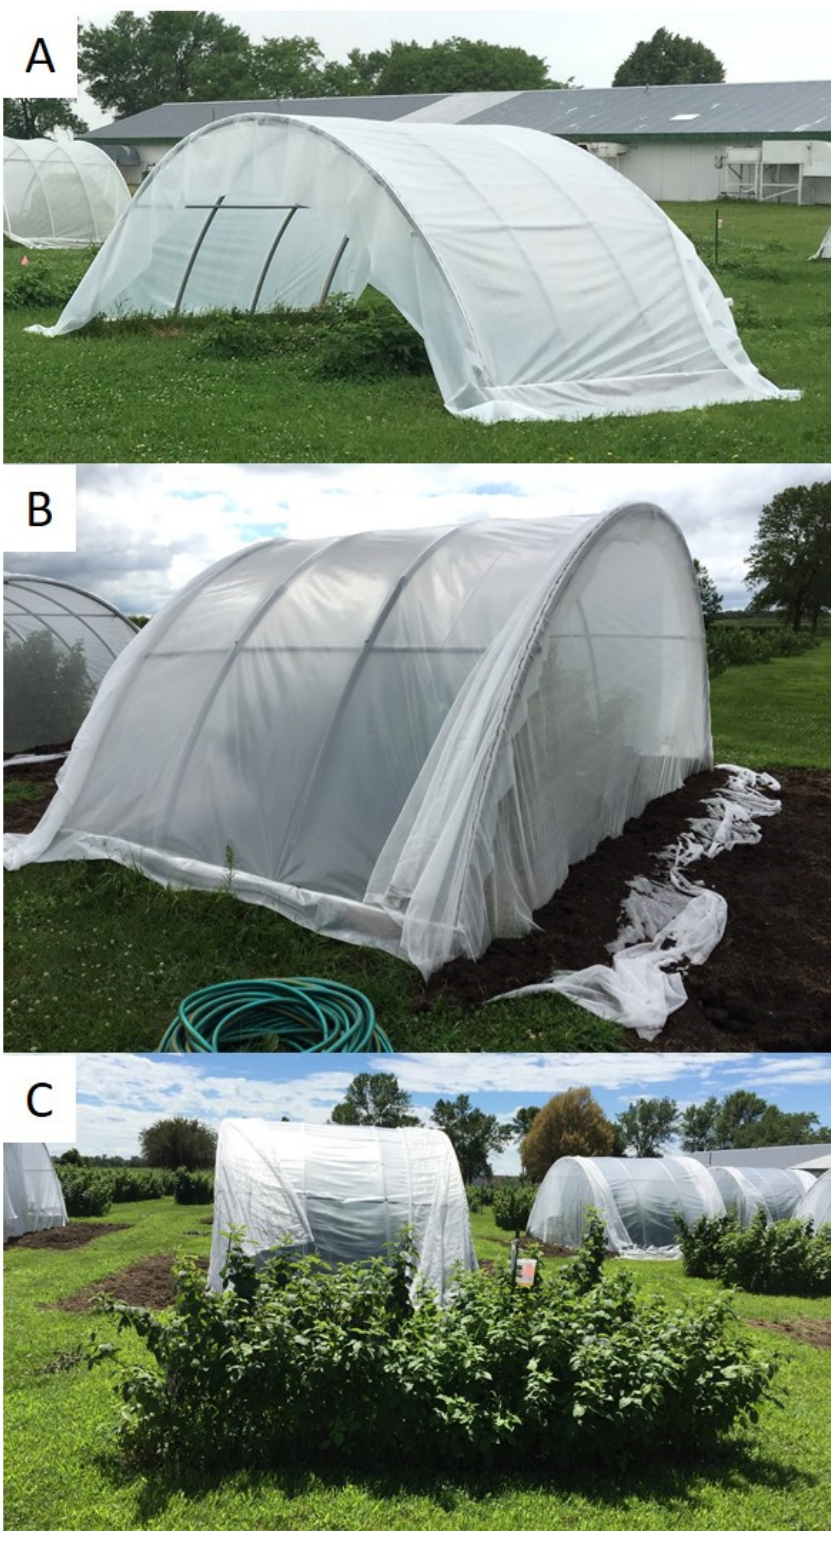
Figure 2. Primocane bearing red raspberry, ‘Heritage’, under high tunnels covered with standard poly plastic prior to installing mesh netting end pieces ( A ), after mesh netting ends were installed and buried with soil ( B ), and nearby open plots (untreated check) with no high tunnel structure or coverings ( C ); all treatments were arranged within a randomized complete block design, with 4 replications each, Rosemount Research & Outreach Center, MN, 2017–2019.